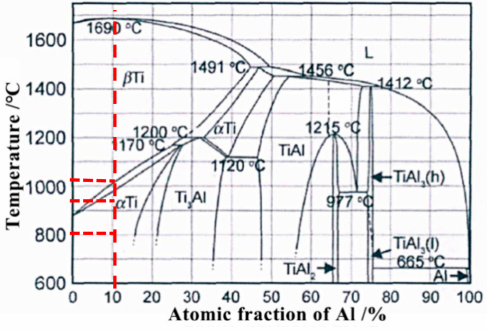
Figure 6. Ti-Al binary alloy phase